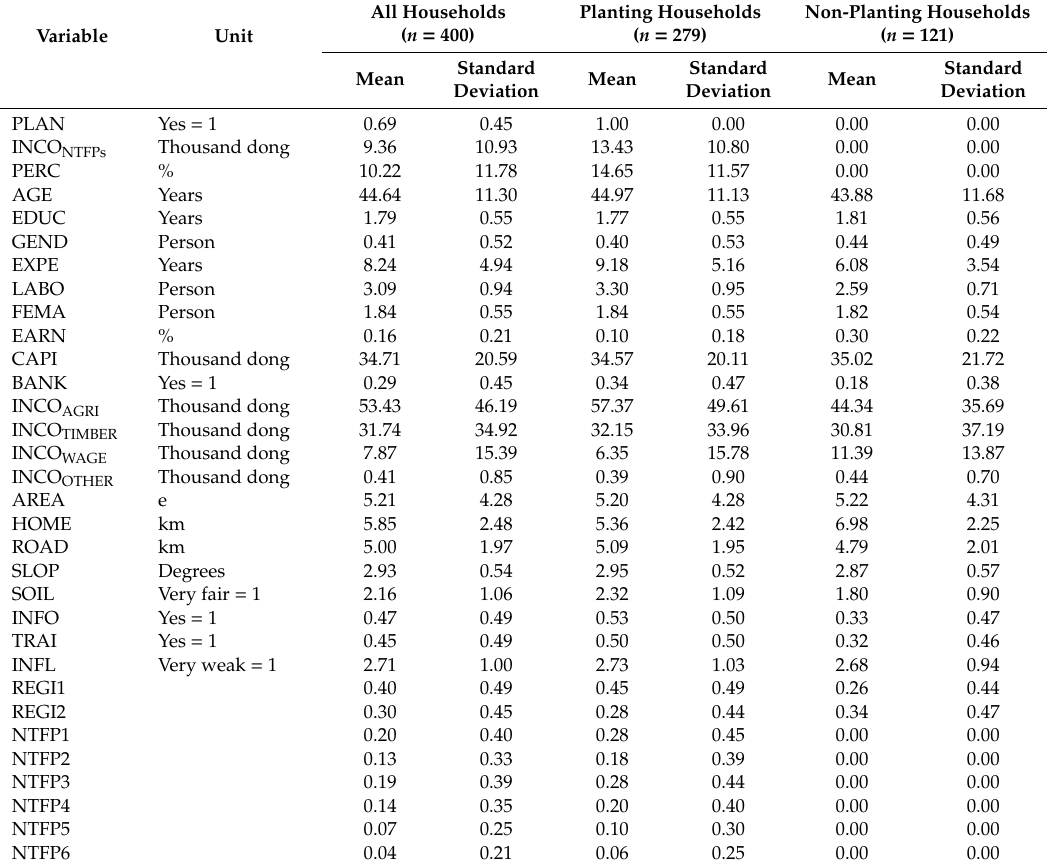
Table A3. Descriptive statistics of explanatory